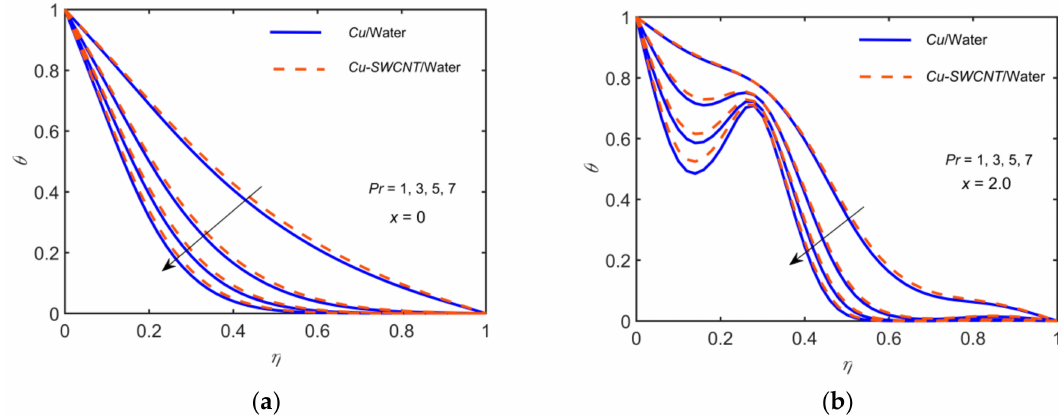
Figure 12. Comparison of Cu /water and Cu – SWCNT /water for the temperature profiles for Pr = 1,3, 5, and 7, St = 0.02 with M = 5, Rd = 0.2, Re = 700, φ = 0.02, and t = 0.25 at ( a ) x = 0 ( b ) x = 2.